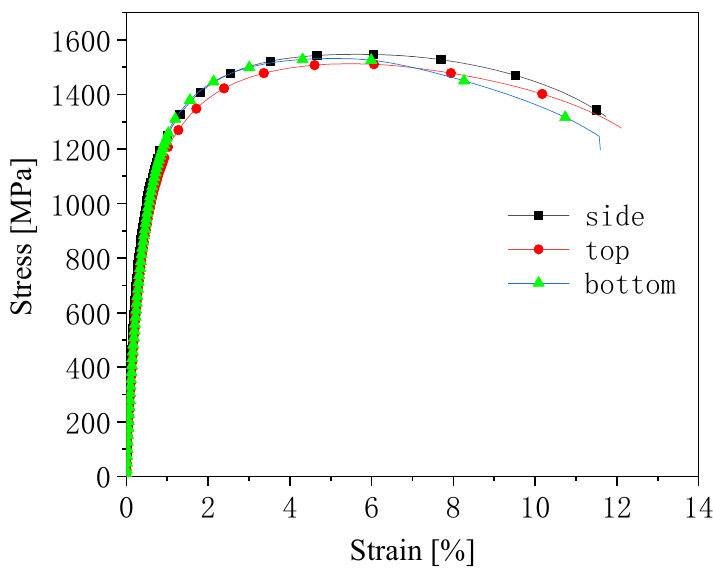
Figure 5. Engineering stress–strain curve of hot-stamping parts in different positions. Table 3. Tensile properties of hot-stamping parts. Specimen